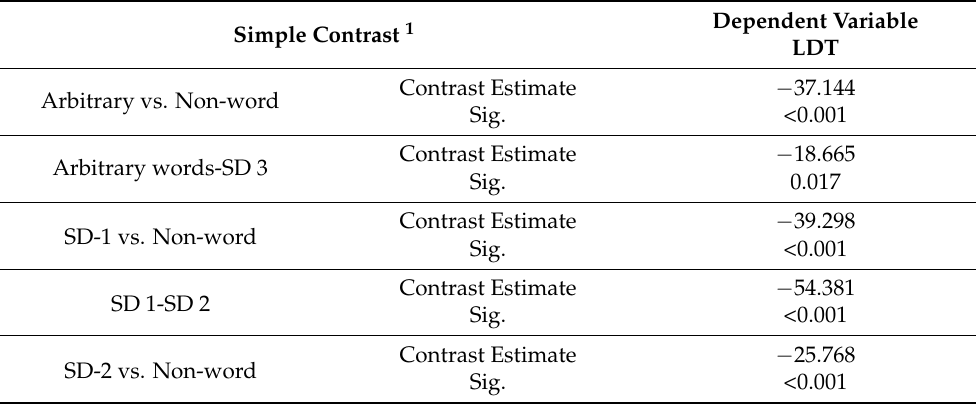
Table 11. Comparison of the Reaction Time to Non-Words and Target Stimuli in